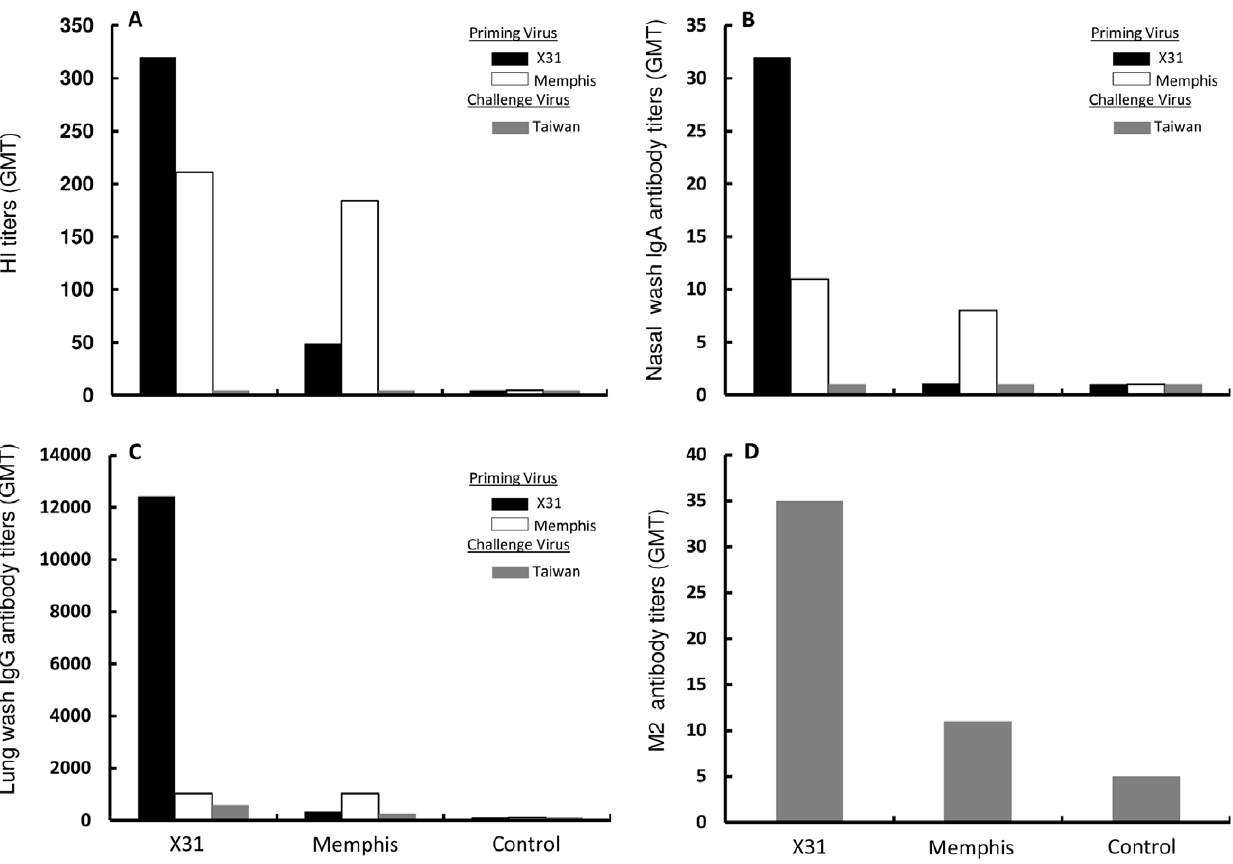
Figure 2. Strain-specific and cross-reactive antibodies following lethal challenge of primed mice with heterosubtypic influenza A virus. Five B6 mice per group were primed intranasally as described in figure 1. Serum, lung and nasal washes were sampled from individual animals at day 37 after priming and tested for serum HI titers (A), nasal wash IgA titers (B), lung wash IgG titers (C) against homotypic as well as heterosubtypic influenza A viruses as indicated. Serum IgG antibody titers to M2 protein was determined by an ELISA using synthetic M2e peptide as antigen (D).